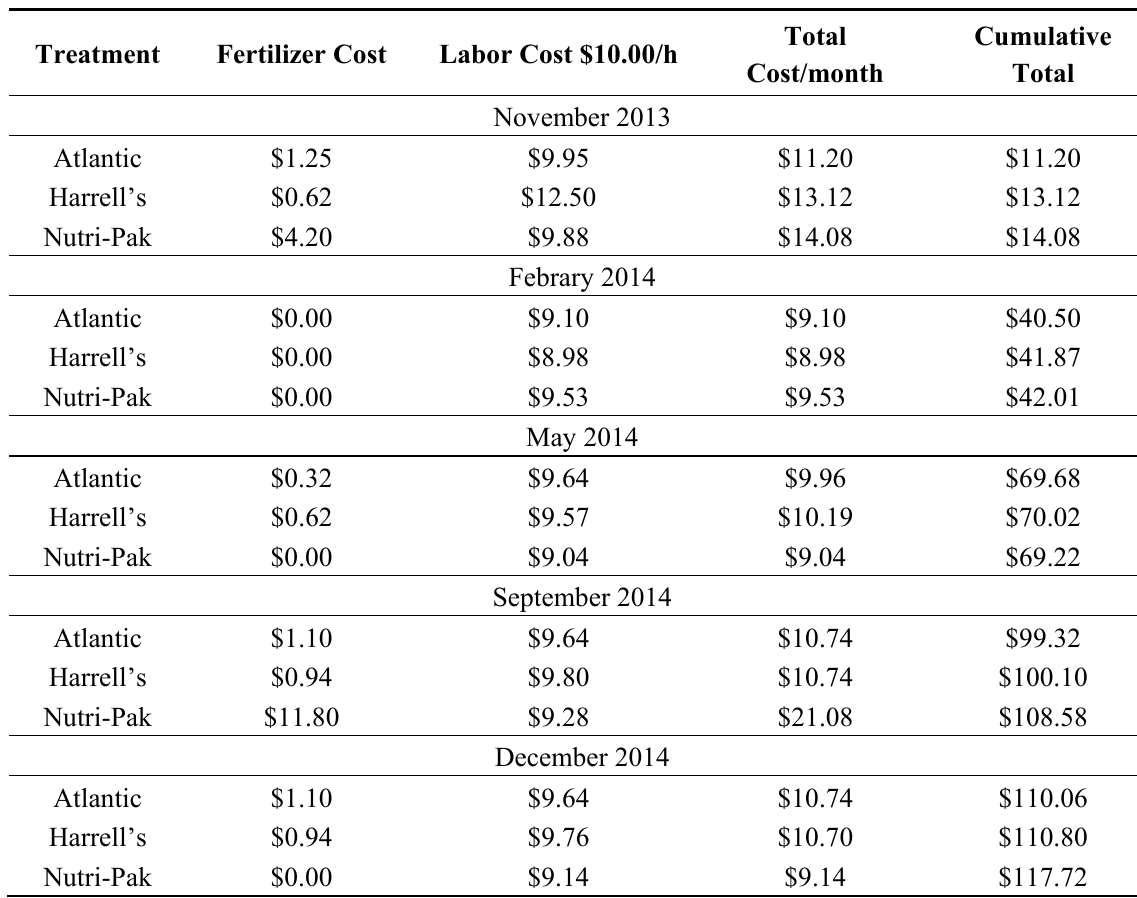
Table 2. Cost analysis for maintenance of two palm species fertilized with Atlantic, Harrell’s or Nutri-Pak palm fertilizer for 17 months of